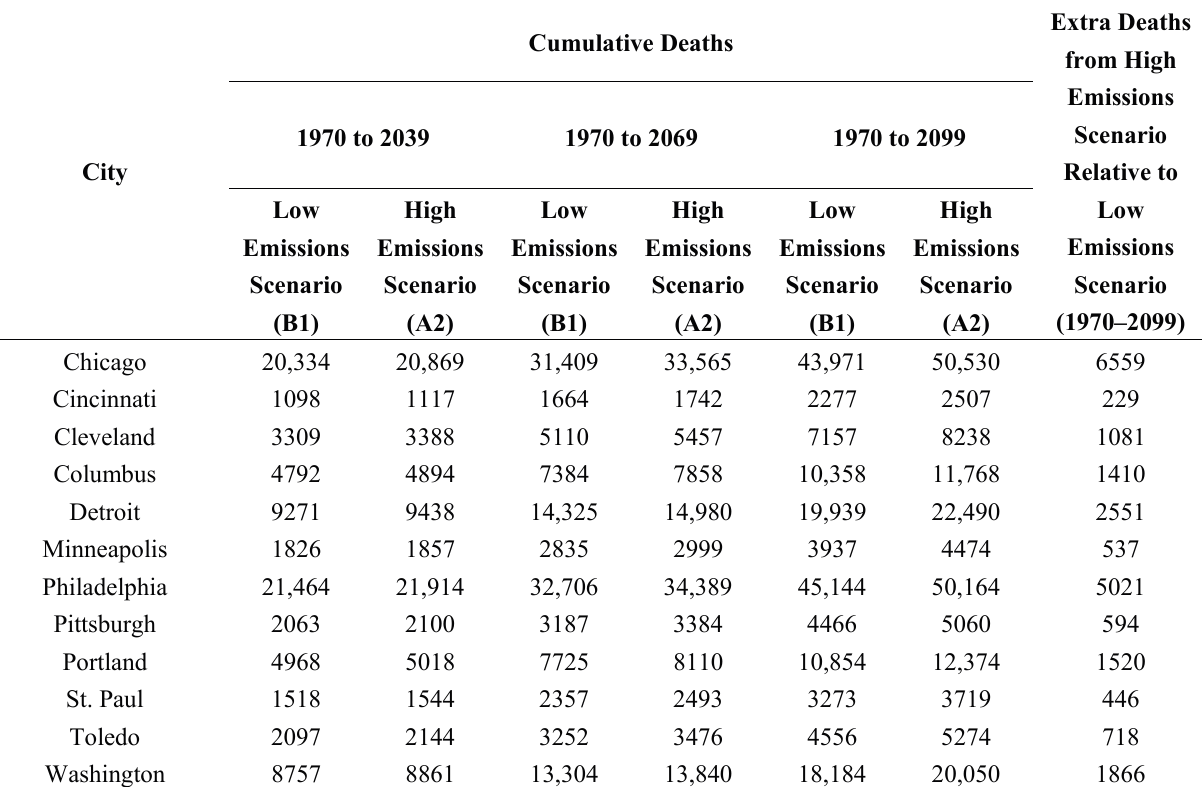
Table 4. Cumulative median heat-related premature deaths by the end of each future decade, 1970–2039, 1970–2069 and 1970–2099. Calculated as a sum of annual median heat-related deaths since the beginning of the baseline period. Annual heat-related deaths between 2000 and 2009 were